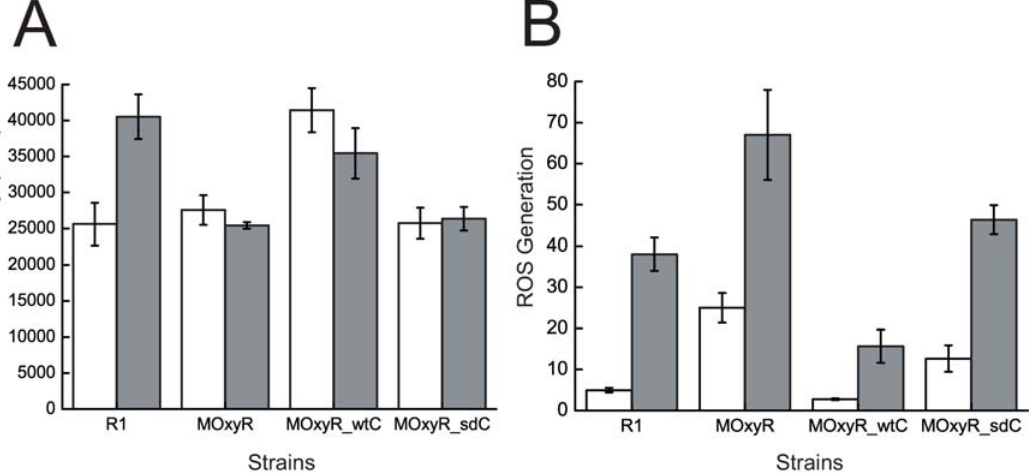
Figure 3. Effect of oxyR disruption on the antioxidant ability of D.radiodurans . (A) Catalase activities of R1, MOxyR, MOxyR_wtC, and MOxyR_sdC after H 2 O 2 treatment (grey bar) or not (white bar). (B) ROS accumulate in four strains after H 2 O 2 treatment (grey bar) or not (white bar). Data reported represent the average and standard deviations of three independent experiments.